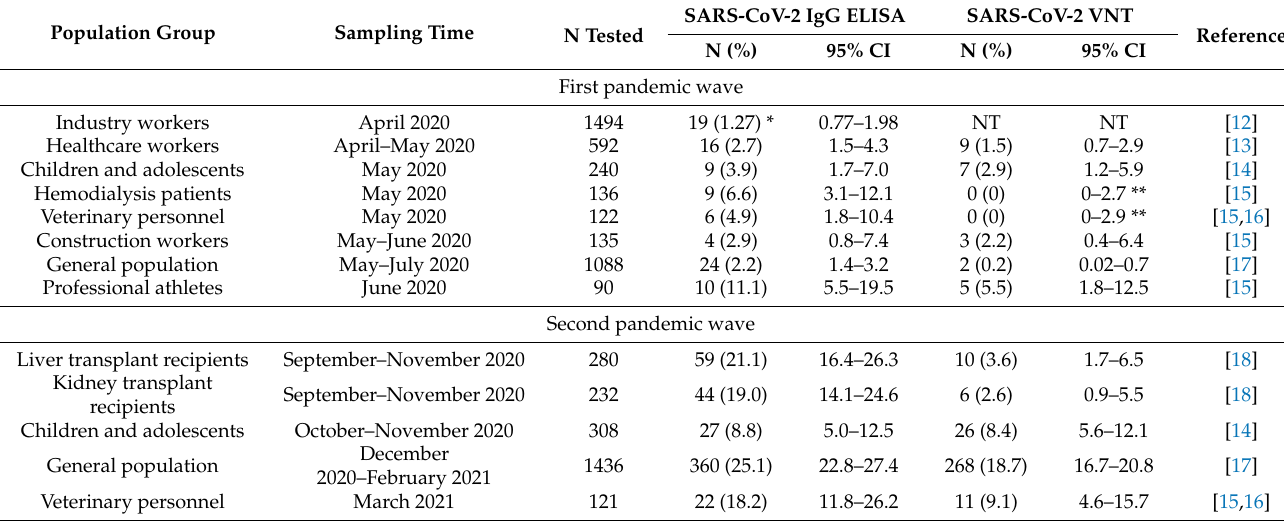
Table 1. Seroprevalence of SARS-CoV-2 in different population groups in